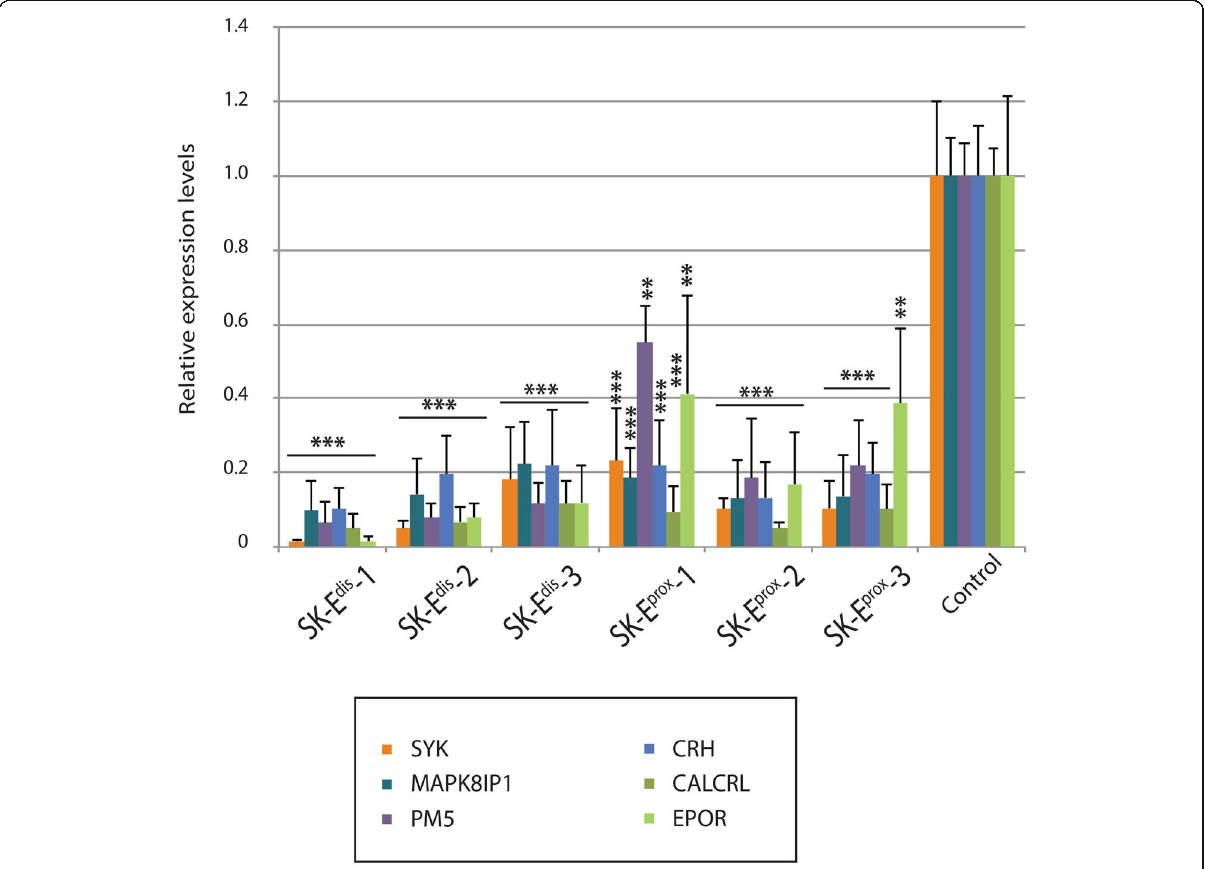
Fig. 3 Graphical representation of qRT – PCR analysis of SYK, MAPK8IP1, PM5, CRH, CALCRL and EPOR FOXP2 target genes in SK-N-MC FOXP2- E proximal or FOXP2-E distal enhancers deleted cells and control SK-N-MC cell electroporated with the pLV-U6 #x H1 #y -C9G empty vector. n = 3. mean ± s.e.m. * P = 0.01 – 0.05, ** P = 0.001 – 0.01, ***P= 0.001 – 0.0001, unpaired two-tailed Student ’ s